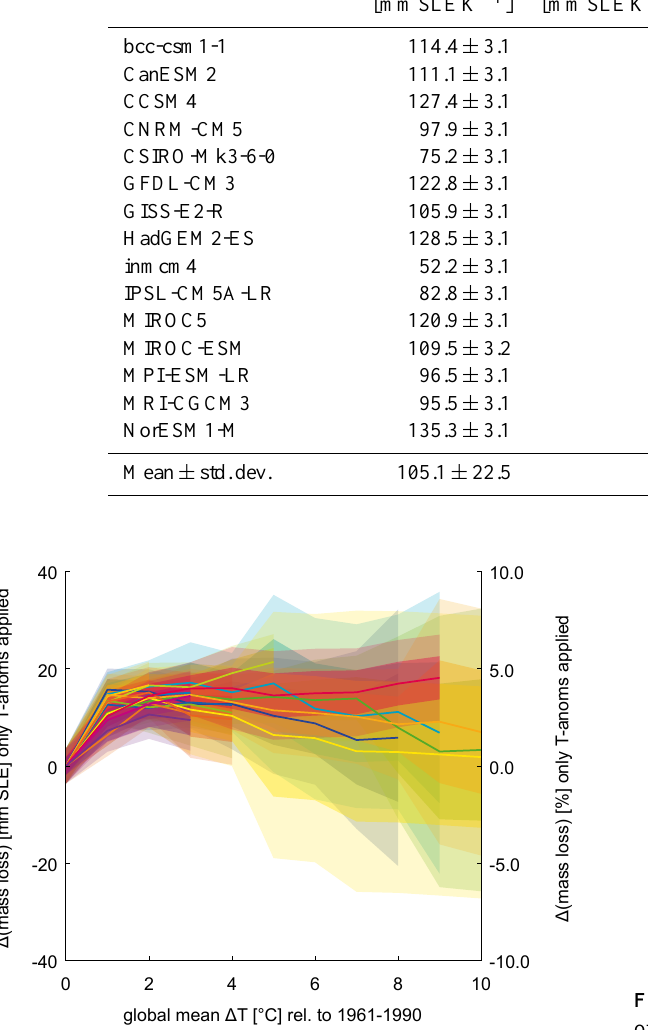
Table 2. Equilibrium sensitivities obtained as the difference between the equilibrium states at global mean 1T = 0K and global mean 1T = 1K, and the anomalies of these sensitivities when either precipitation or temperature anomalies are ignored. Model Equilibrium sensitivity 1 (equi. sensitivity) 1 (equi. sensitivity) [mmSLEK − 1 ] [mmSLEK − 1 ] at P = const.